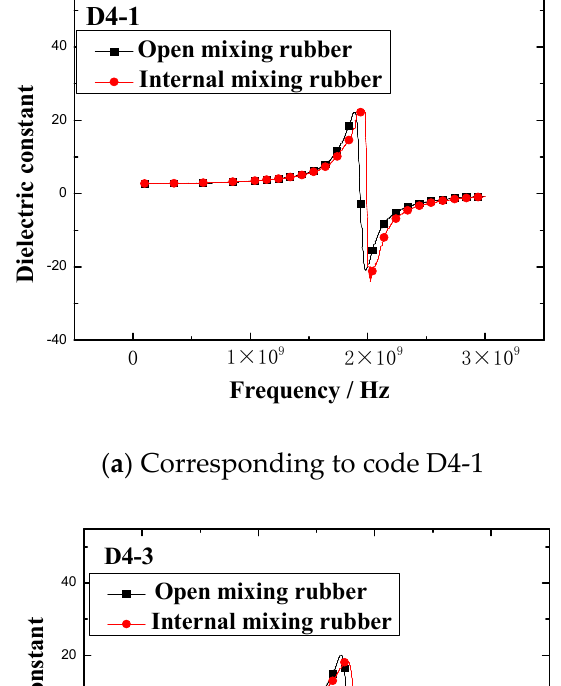
6 of 18 Figure 3. The process flow diagram of the open mixing technology. Figure 4. The process flow diagram of the internal mixing technology. 3. Results and Discussion 3.1. Effect of the Mixing Process According to the rubber mixing formula four, the rubber samples containing differ- ent mass CB were prepared by using the open mill and internal mixer. The codes of the experimental rubber samples corresponding to formula four are shown in Table 5. Table 5. The codes of the rubber mixing. Code